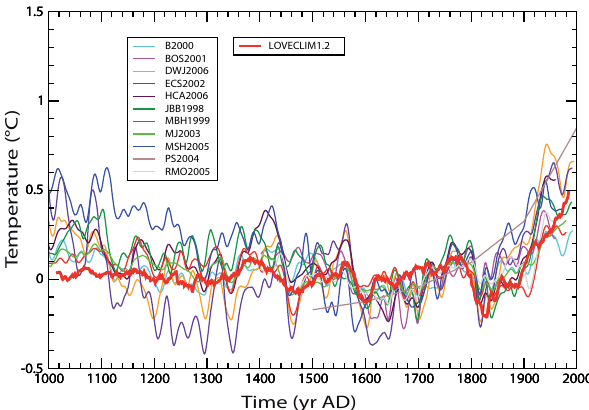
Fig. 15. Annual mean temperature averaged over the Northern Hemisphere in LOVECLIM1.2 (red line) driven by both natural and anthropogenic forcings as well as in several reconstructions based on proxy data. The time series are smoothed with a 31-yr running-mean. The reference period is 1500-1899. The correspondence of acronyms is: B2000 to Briffa (2000) calibrated by Briffa et al. (2004), BOS2001 to Briffa et al. (2001), DWJ2006 to D’Arrigo et al. (2006), ECS2002 to Esper et al. (2002), recalibrated by Cook et al. (2004a), HCA2006 to Hergel et al. (2006), JBB1998 to Jones et al. (1998) calibrated by Jones et al. (2001), MBH1999 to Mann et al. (1999), MJ2003 to Mann and Jones (2003), MSH2005 to Moberg et al. (2005), PS2004 Pollack and Smerdon (2004), reference level adjusted following Moberg et al. (2005), RMO2005, Rutherford et al. (2005).